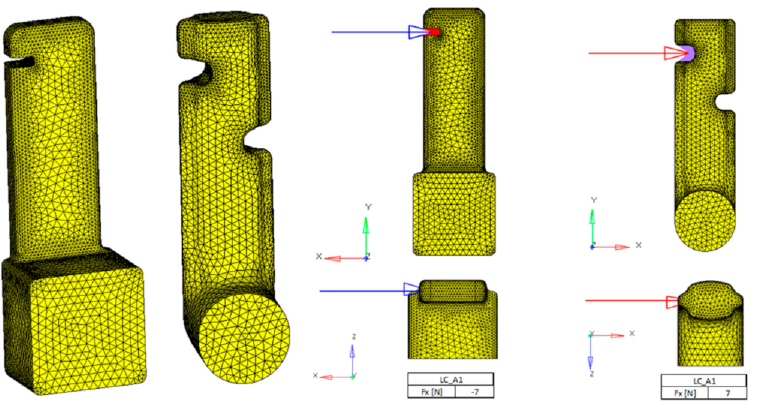
Figure 12. Meshed power-arms on the left, and load condition LC_A1 on the right.